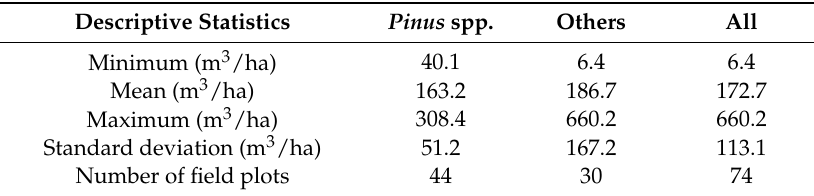
Table 1. Summary statistics for the growing stock volume.